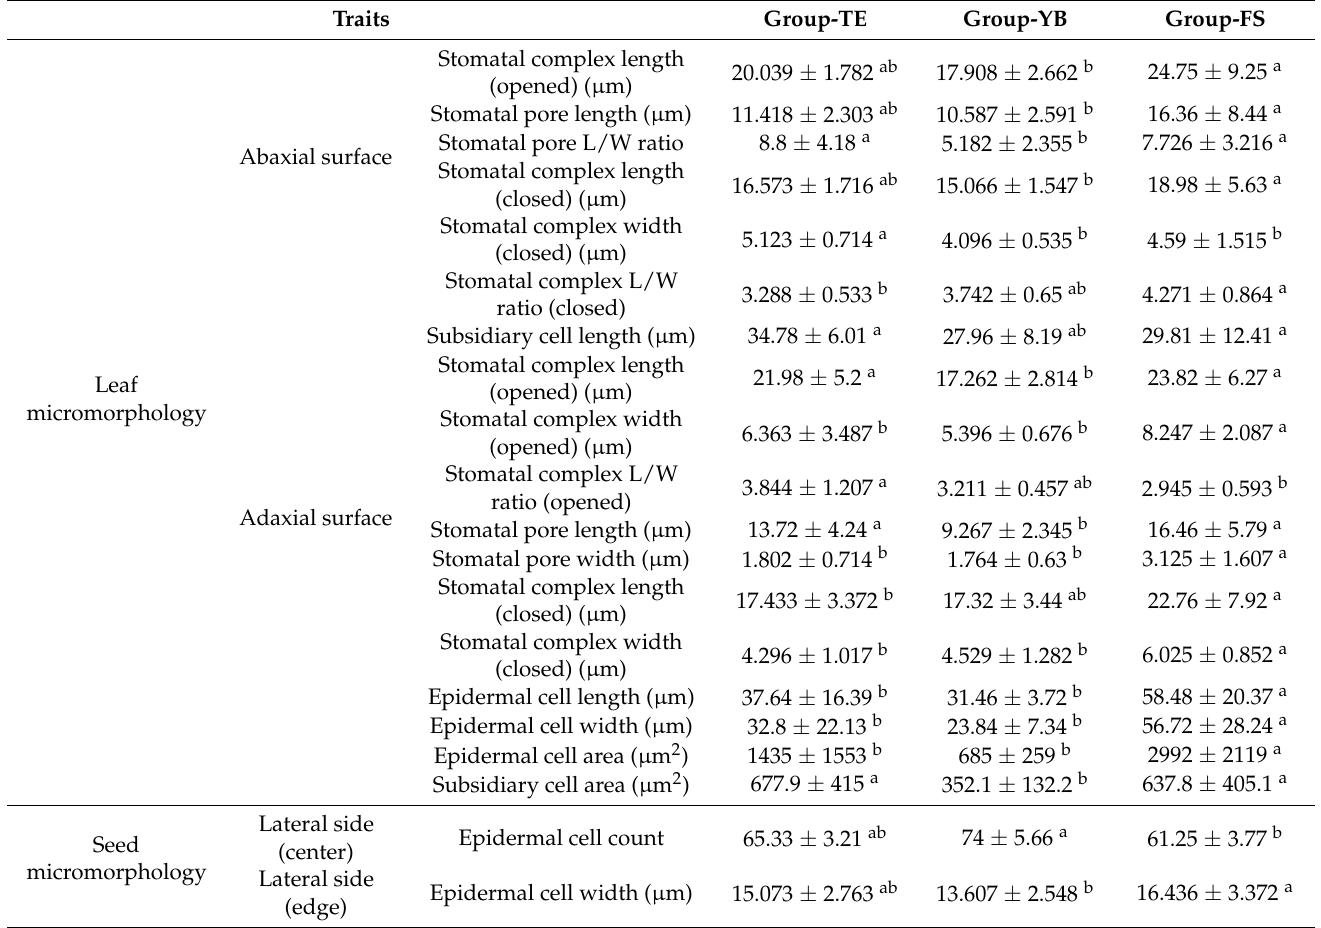
Table 3. One-way ANOVA results and pairwise comparisons among the three groups of Trianthema portulacastrum , showing the significant leaf and seed micromorphological traits. Groups that share same letters are non-significant while different letters represent significantly different groups.